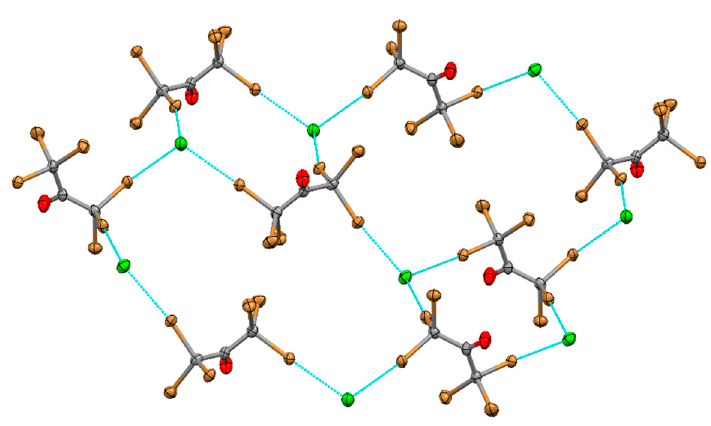
Figure 3. XB network formed by hexabromoacetone and Cl − anions in (Pr 4 N)Cl · CBr 3 COCBr 3 co-crystals.